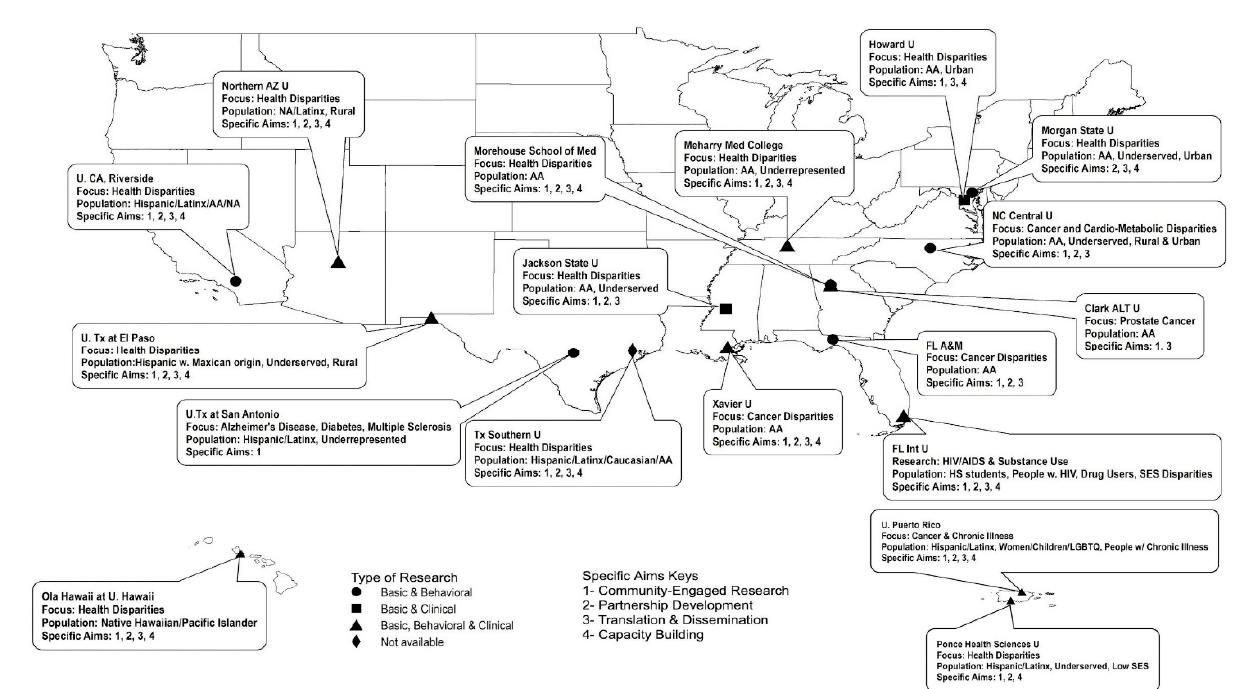
Figure 1. RCMI Community Engagement Components, Specific Aims & Target Populations.